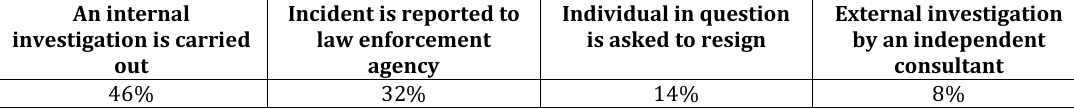
Table 12: Response about the Process Followed to Handle Fraud Incidents in Banks An internal investigation is carried